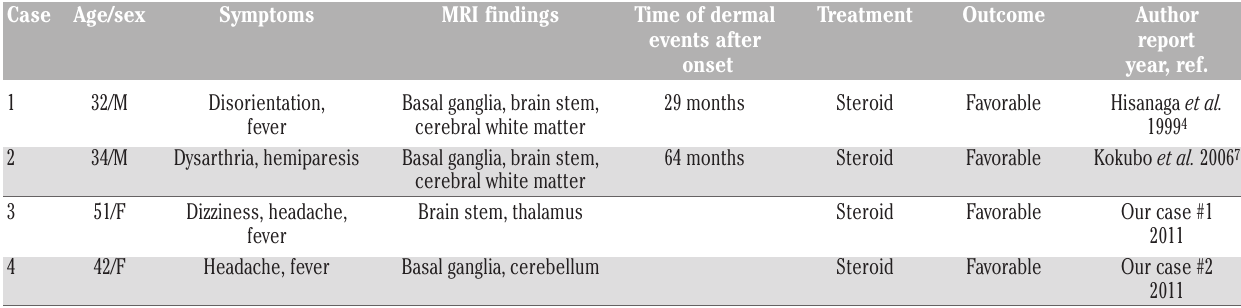
Table 1. Clinical features of acute meningoencephalitis as the initial manifestation in neuro-Sweet disease. Case